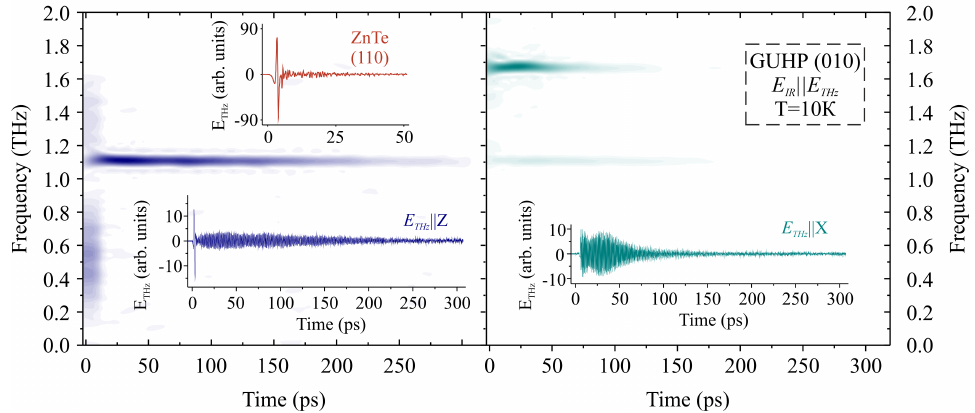
Figure 27. Spectrochronographic image of the time-frequency distribution of a THz pulse generated in a GUHP crystal at T = 10 K. The insets show the time profiles of the electric field of these THz pulses together with, for comparison, the time profile of the THz pulse from a 300 µ m thick ZnTe (110) crystal at room temperature. © 2022 IEEE. Reprinted with permission from